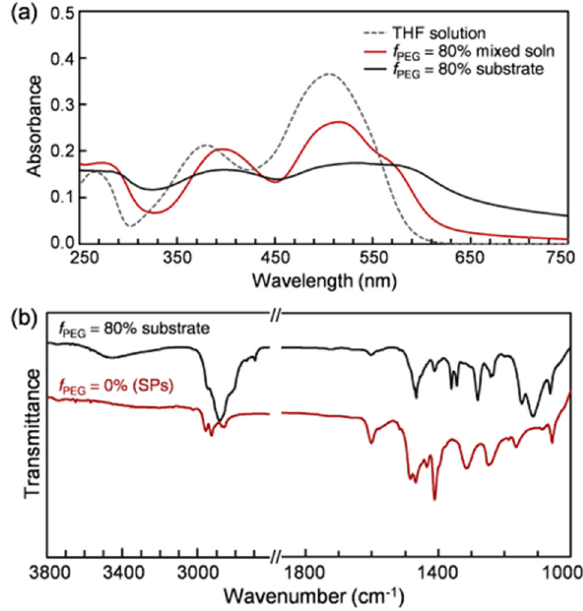
Figure 6. ( a ) UV-vis absorption and ( b ) FT-IR spectra.